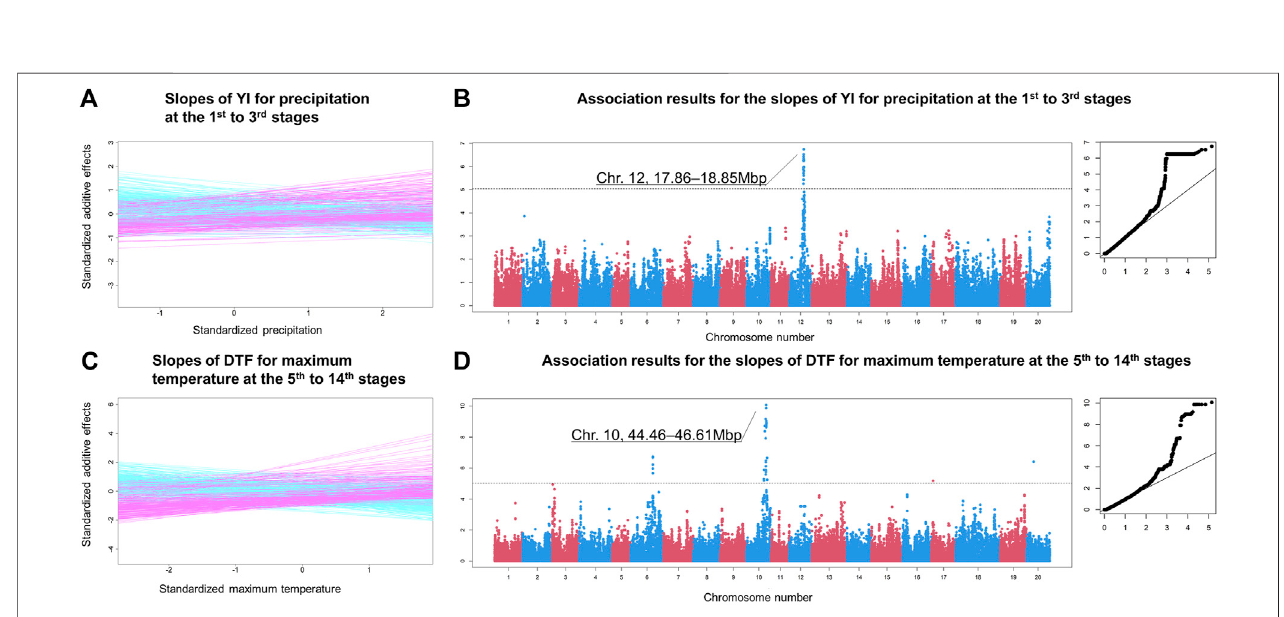
FIGURE 6 | Examples of the genome-wide association mapping results. (A) Slopes of YI for precipitation at the 1st to 3rd growth stages. The x and y axes are the environmental covariates and the additive genetic effects, respectively. Both axes are standardised. (B) Manhattan and QQ plots of the association analysis of the slopes illustratedin (A) .Thehorizontaldashedlineindicatesthefalsediscoveryrate(0.05)threshold.The x and y axesoftheQQplotaretheexpectedandobserved − log10 p values, respectively. (C) Slopes of days to fl owering for maximum temperature at the 5th to 14th growth stages. (D) Manhattan and QQ plots for the slopes illustrated in (D) .